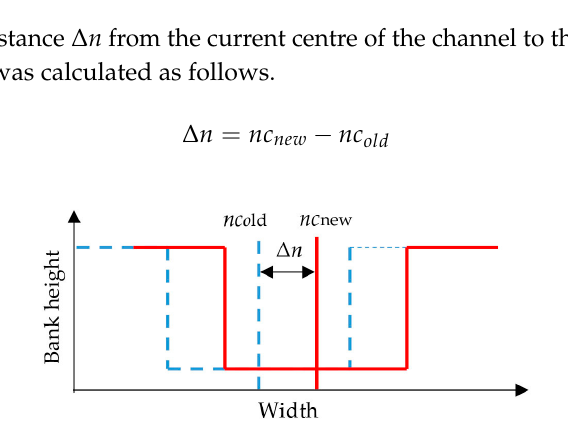
Figure 2. Cross centreline migration (Blue: old cross section, red: New cross section).